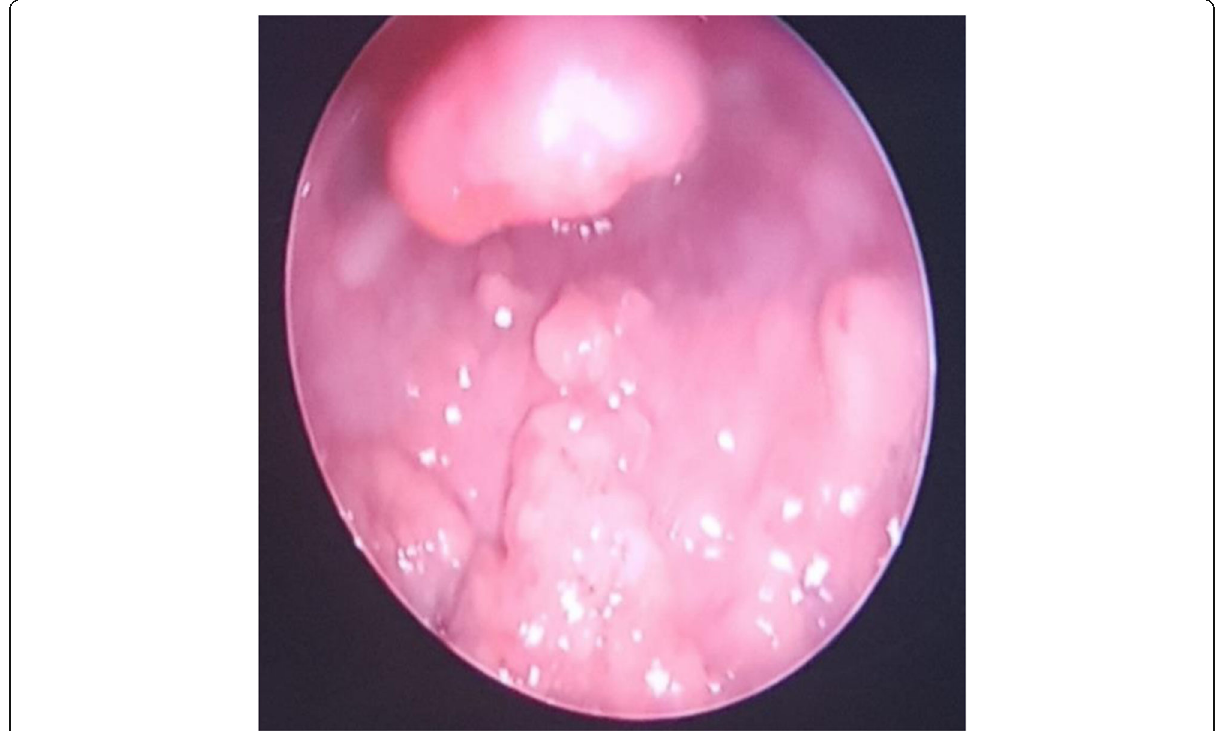
Fig. 1 Hypertrophic granulations over posterior pharyngeal wall with oedematous, granular